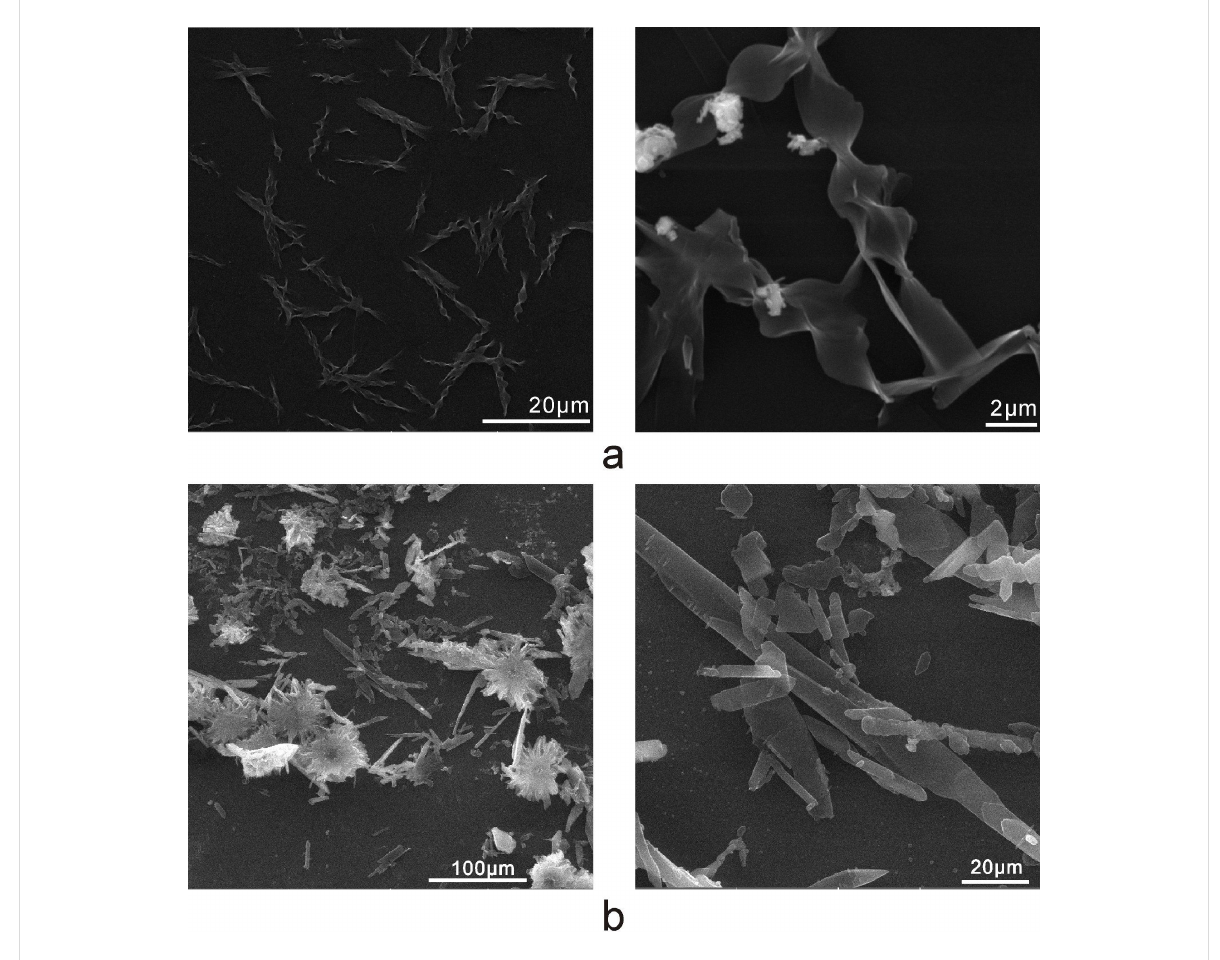
Figure 2: SEM images of T 1 (a) and T 2 (b) films on glass substrates (drop-coated from diluted T 1 or T 2 solution).